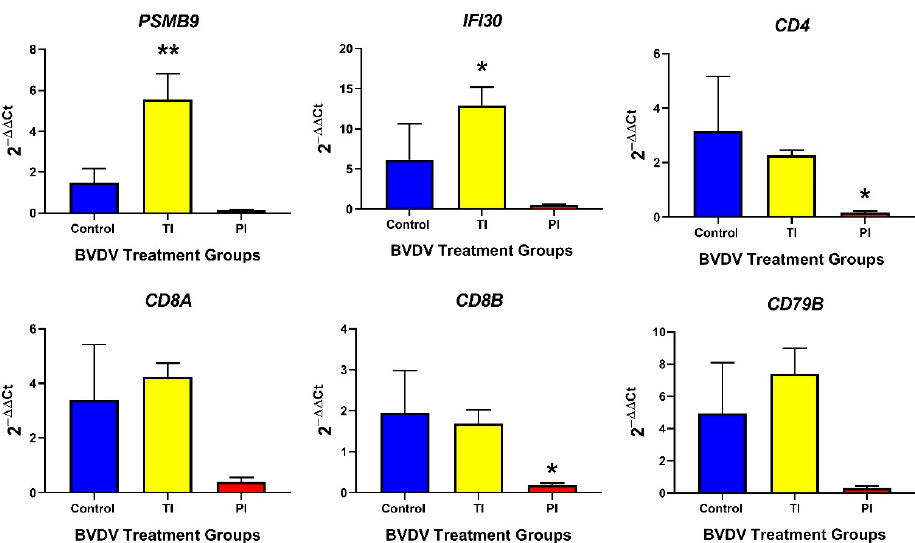
Figure 5. Splenic (Control, TI, and PI) expression of transcripts associated with the adaptive immune response. In TI fetal spleens, only PSMB9 and IFI30 , associated with antigen presentation, were significantly di ff erent to the controls. In PI fetal spleens, T cell markers CD4 and CD8A were significantly downregulated compared to controls. TI: Transiently Infected, PI: Persistently Infected. * p < 0.05, ** p < 0.01.